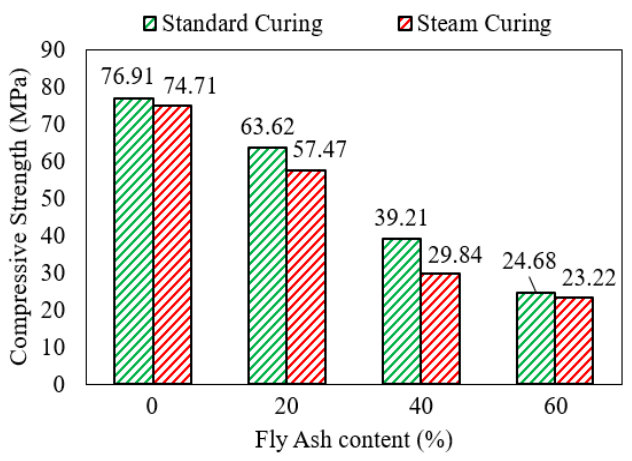
Figure 9. Steam curing resulted in slightly lower 28-day compressive strength than standard curing with an AASF binder for a fly ash content up to 60% [38].